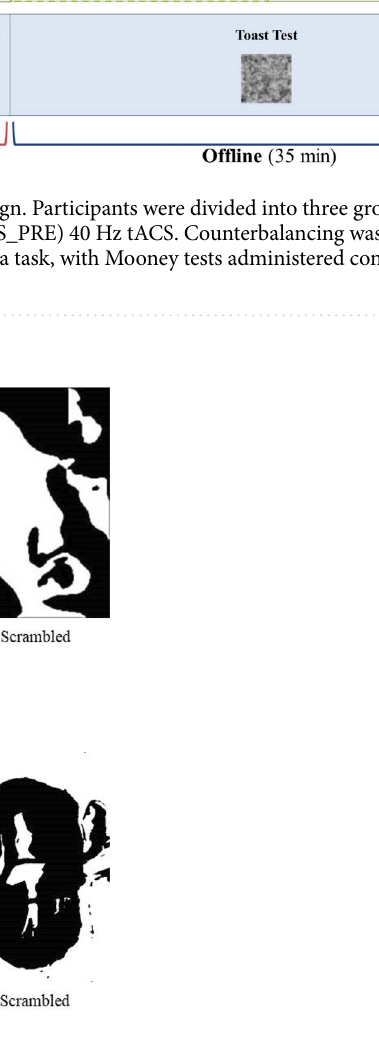
Figure 2. Sample stimuli in the Mooney test for faces (top), and the Mooney test for objects (bottom). Upright face ( a ), inverted face ( b ), and scrambled face ( c ); upright object ( d ), inverted object ( e ), and scrambled object ( f ) 63